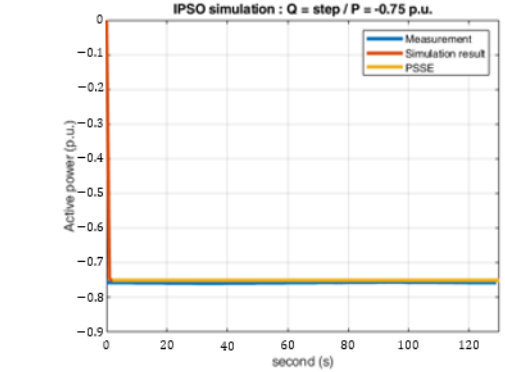
Figure 23 . The IGA ( left ) and IPSO ( right ) fitting waveform 1 fitting results . Figure 24. The IGA ( left ) and IPSO ( right ) fitting waveform 2 fitting results . This study considered the universality of the BESS model. We eliminated control blocks that could not be used due to the control strategy, and then used an optimization algorithm to find the parameters that could minimize the object function. The results of this study showed that the response of the BESS in the simulation almost fit the PSS/E and measurement results. Figure 23. The IGA ( left ) and IPSO ( right ) fitting waveform 1 fitting results.